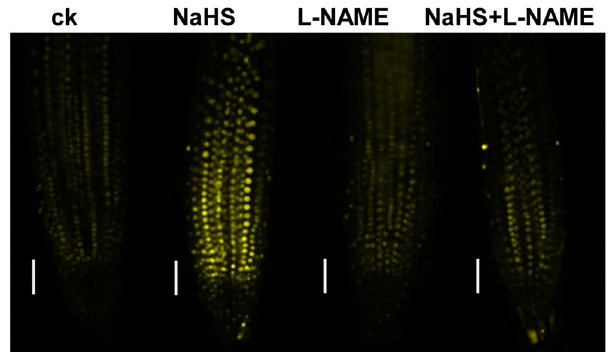
Figure 7. NO is involved in the NaHS-mediated reduction of the distribution of auxin in root tips. YFP fluorescence in the roots of 5-d-old DII - VENUS seedlings exposed to 500 μ M NaHS with or without 500 μ M L-NAME for 24 h. Bars, 50 μ m. n = 30. ck, untreated